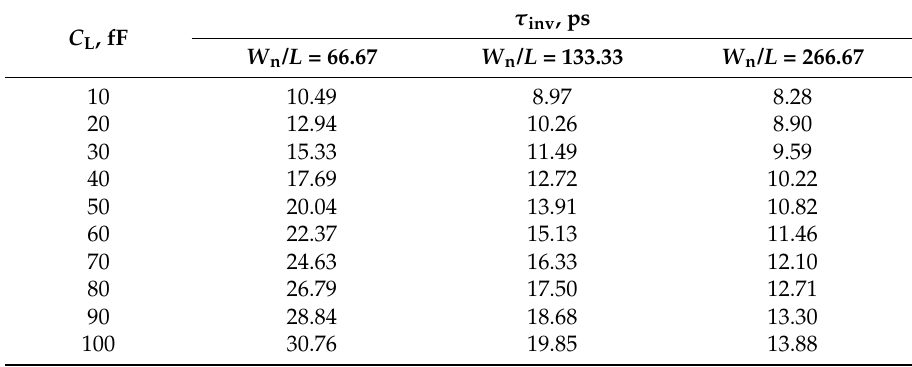
Table 1. Modeling results of dependency of inverter’s delay time on load capacitance and ratio of width and length of transistors in 65 nm CMOS technology.